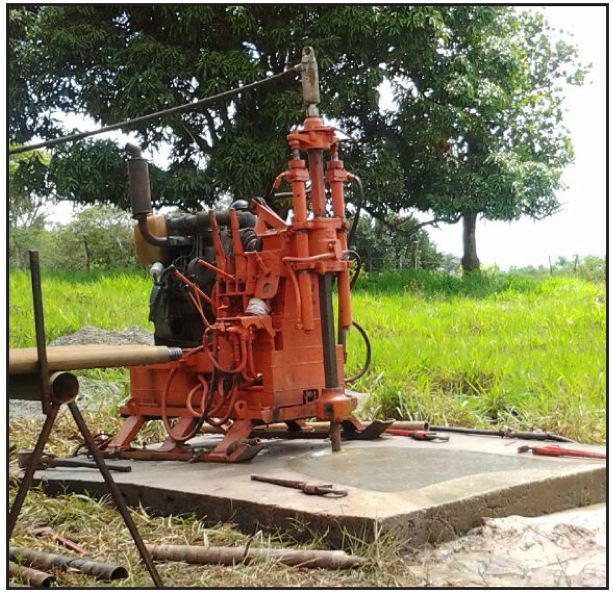
Figure 4. The drilling rig used to retrieve core material for this study was mainly oriented perpendicular to the strata